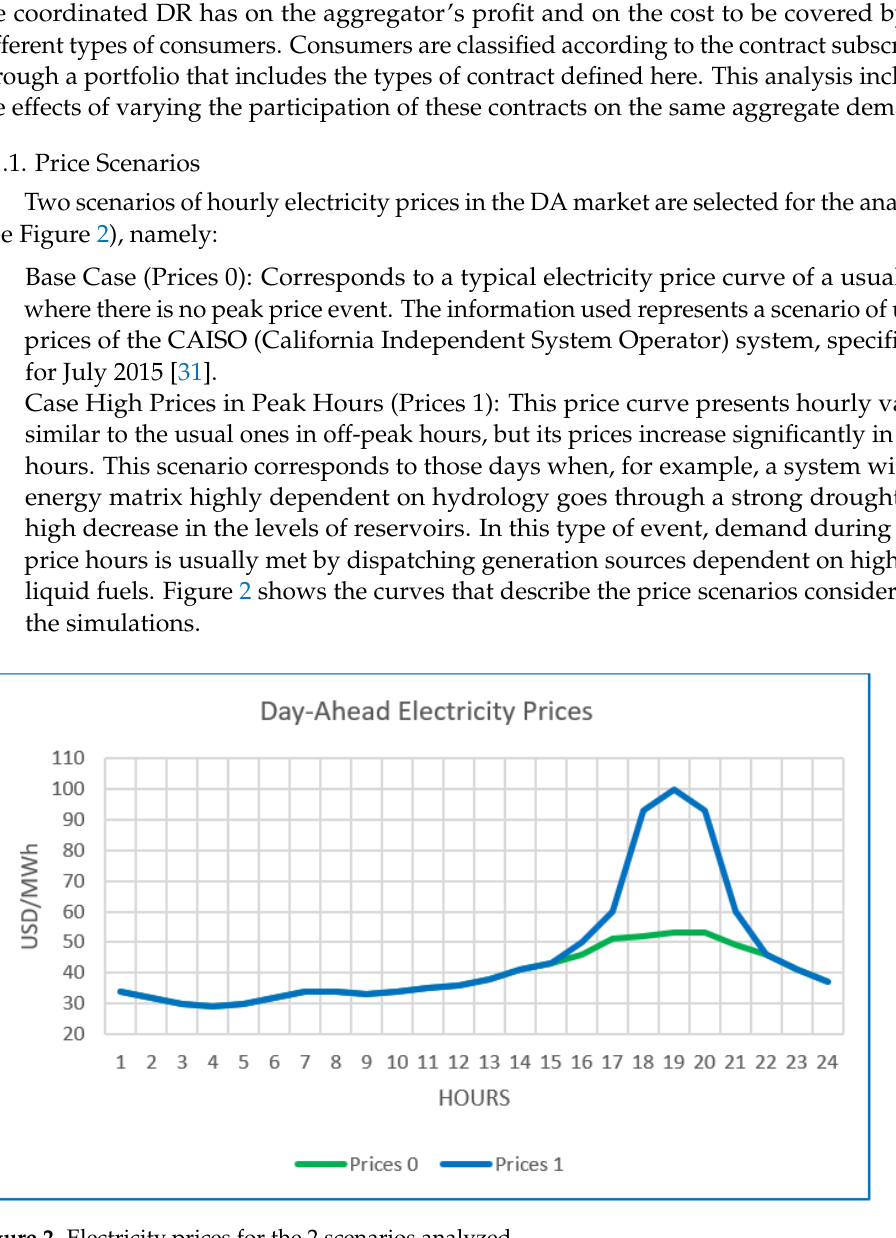
Figure 2. Electricity prices for the 2 scenarios